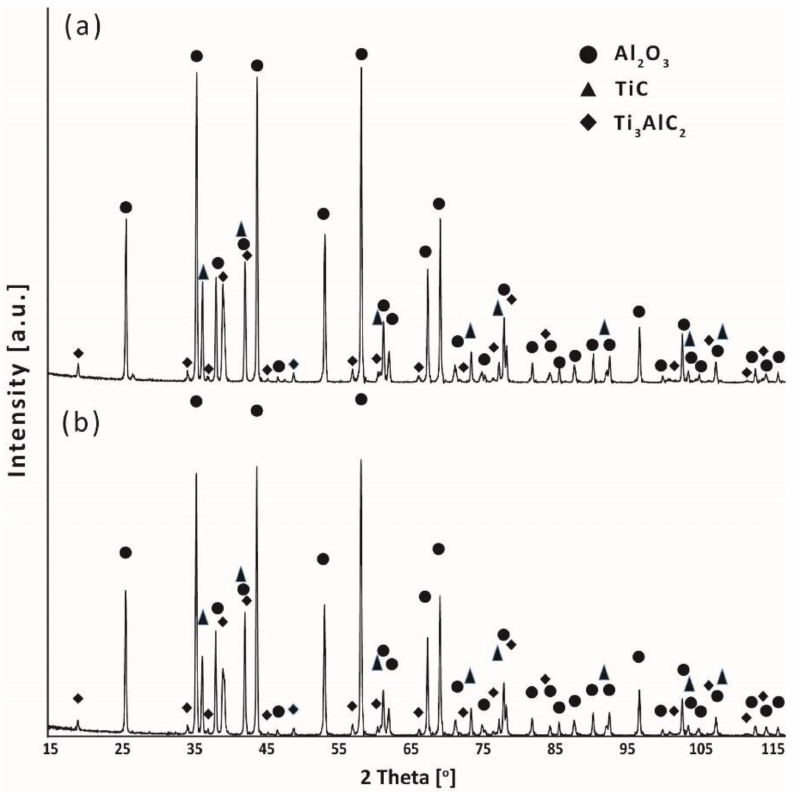
Figure 6. XRD analysis of ( a ) Al 2 O 3 + 20 wt% of Ti 3 AlC 2 addition from horizontal mill, ( b ) Al 2 O 3 + 20 wt% of Ti 3 AlC 2 addition from planetary